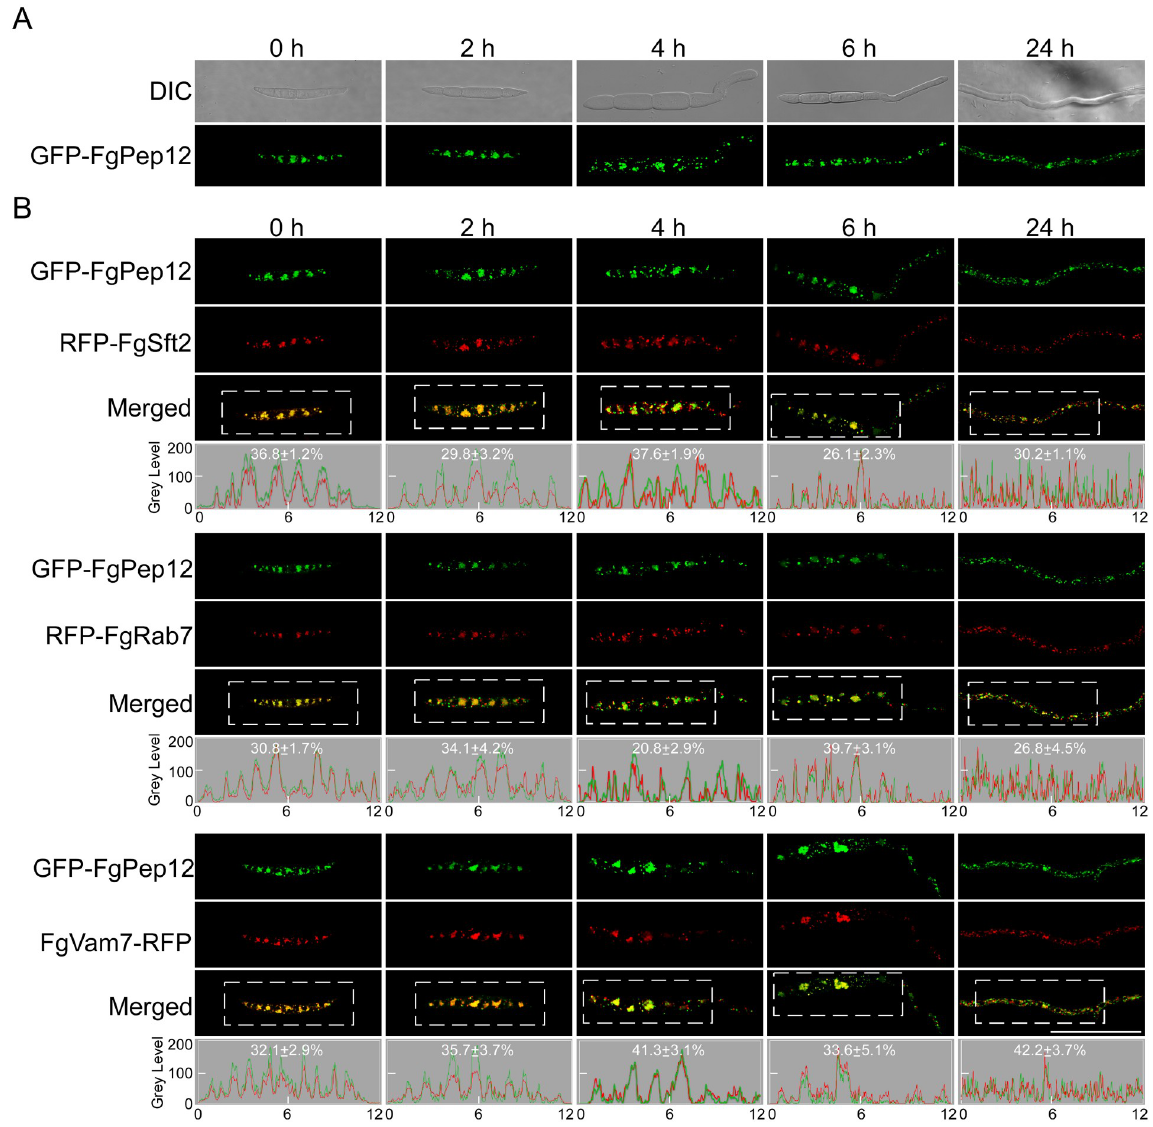
Fig 3. FgPep12 localizes to Golgi, late endosome and vacuole multiple organelles. (A) Expression and localization of GFP-FgPep12 in F . graminearum . Conidia expressing GFP-FgPep12 were germinated in liquid CM medium for 0, 2, 4, 6 and 24 h, and examined under differential interference contrast (DIC) and epifluorescence microscope. (B) Conidia co-expressing GFP-FgPep12&RFP-FgSft2, GFP-FgPep12&RFP-FgRab7 or GFP-FgPep12&FgVam7-RFP constructs were germinated in liquid CM medium for 0, 2, 4, 6 and 24 h, and examined under a confocal microscope. Co-localization of the proteins was further evaluated by linescan graph analysis (grey panel, horizontal axis indicates the distance). The analyzed area was indicated in dashed box. The percentage of the localization signals was yielded by counted the merged dots in conidia (n = 30) or germ tubes (n = 30, per germ tube 10 μ m). Bar = 10 μ m.